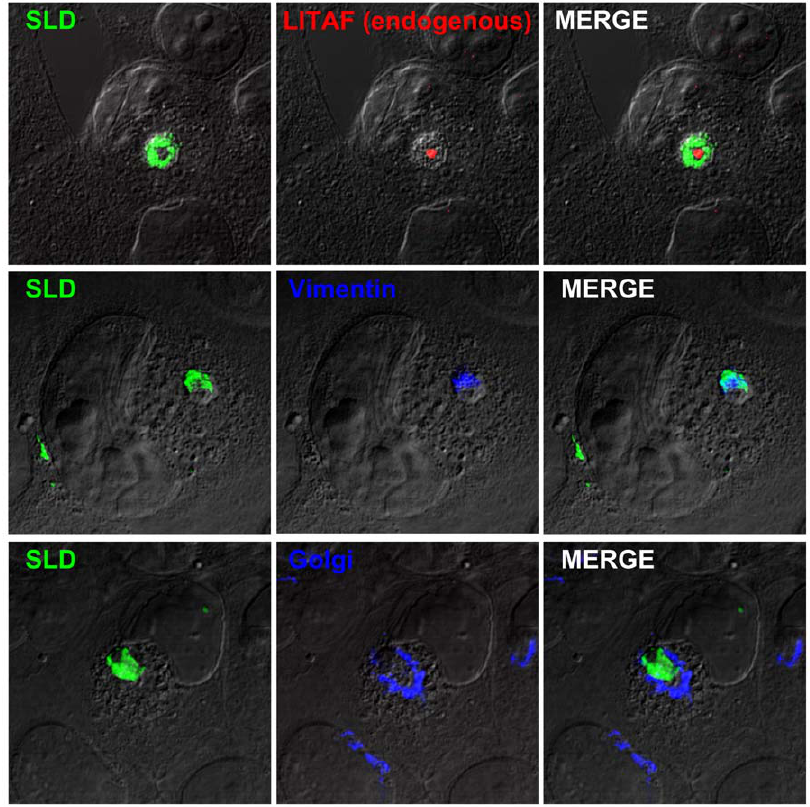
Figure 4. The SLD localizes to the aggresome. BGMK cells were transfected with myc-SLD. Forty-eight hours post-transfection, cells were fixed and immunofluorescence was completed with a variety of cellular markers in order to determine localization of the SLD (green). Endogenous LITAF was detected using an anti-LITAF antibody (red) and vimentin (anti-vimentin antibodies) and the Golgi apparatus (anti-Golgin 97) are visualized in blue. DIC was used to visualize the cell nuclei.